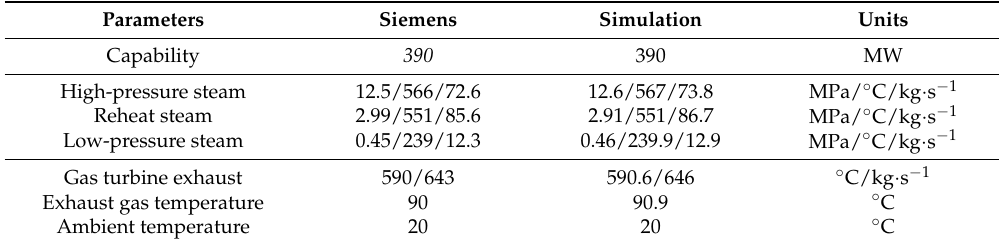
Table 2. Main parameters of Siemens.